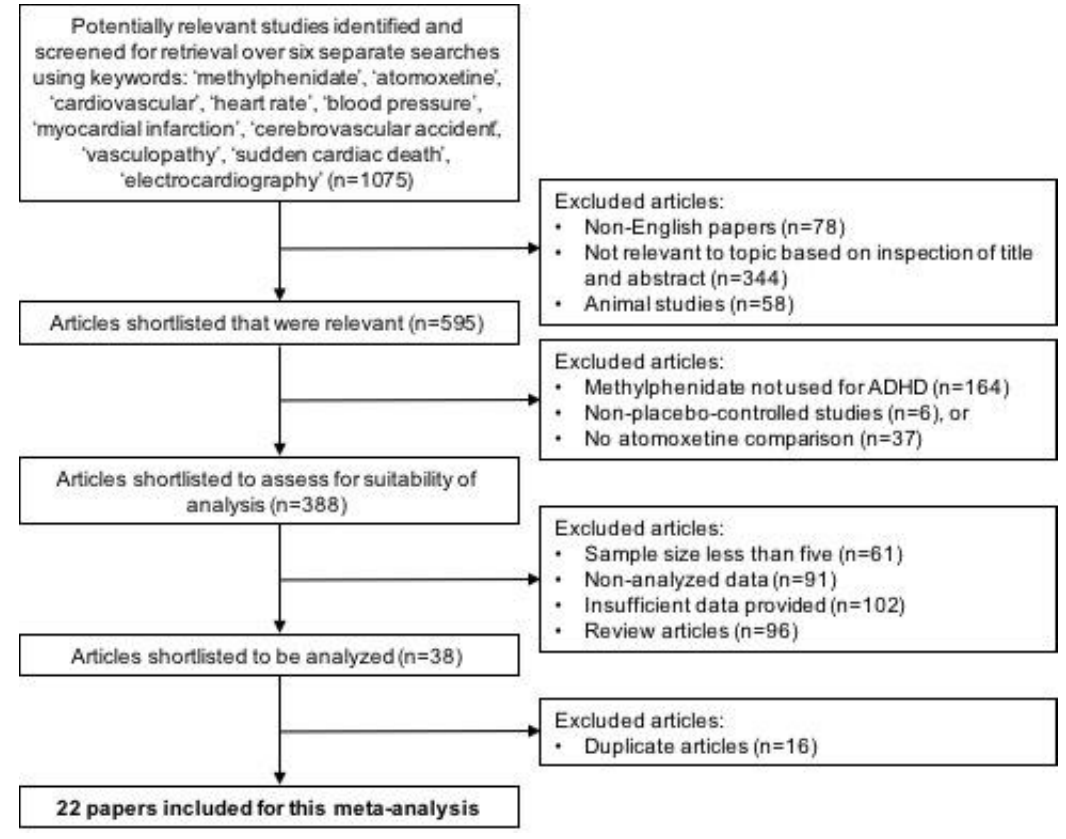
Figure 1. Preferred Reporting Items for Systematic Review and Meta-Analyses (PRISMA) flowchart summarizing results of literature search. Table 1. Characteristics and quality of controlled trials comparing methylphenidate and either placebo or atomoxetine in patients with attention deficit hyperactive disorder.